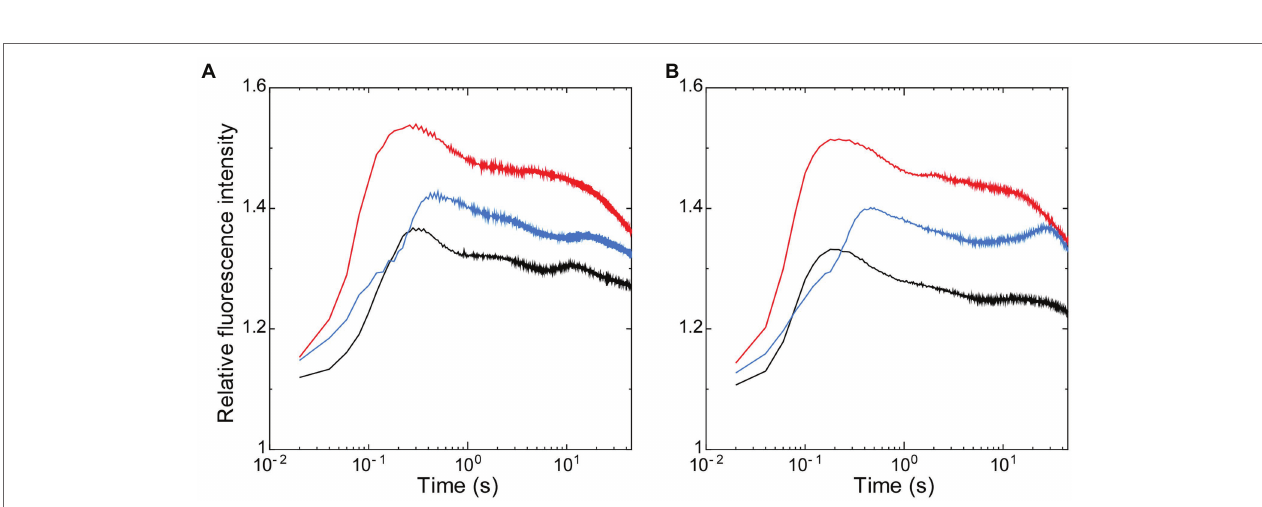
FIGURE 3 | The dark-to-light induction kinetics of chlorophyll fluorescence measured in the absence (A) or presence of glucose (B) . Black line, the wild-type strain; red line, Δ ndhF1 ; and blue line, Δ gnd . Prior to measurements, cells were dark-acclimated for 15 min. The intensity of chlorophyll fluorescence was normalized at the onset of actinic illumination. The average of the kinetics of three independent cultures in each strain is